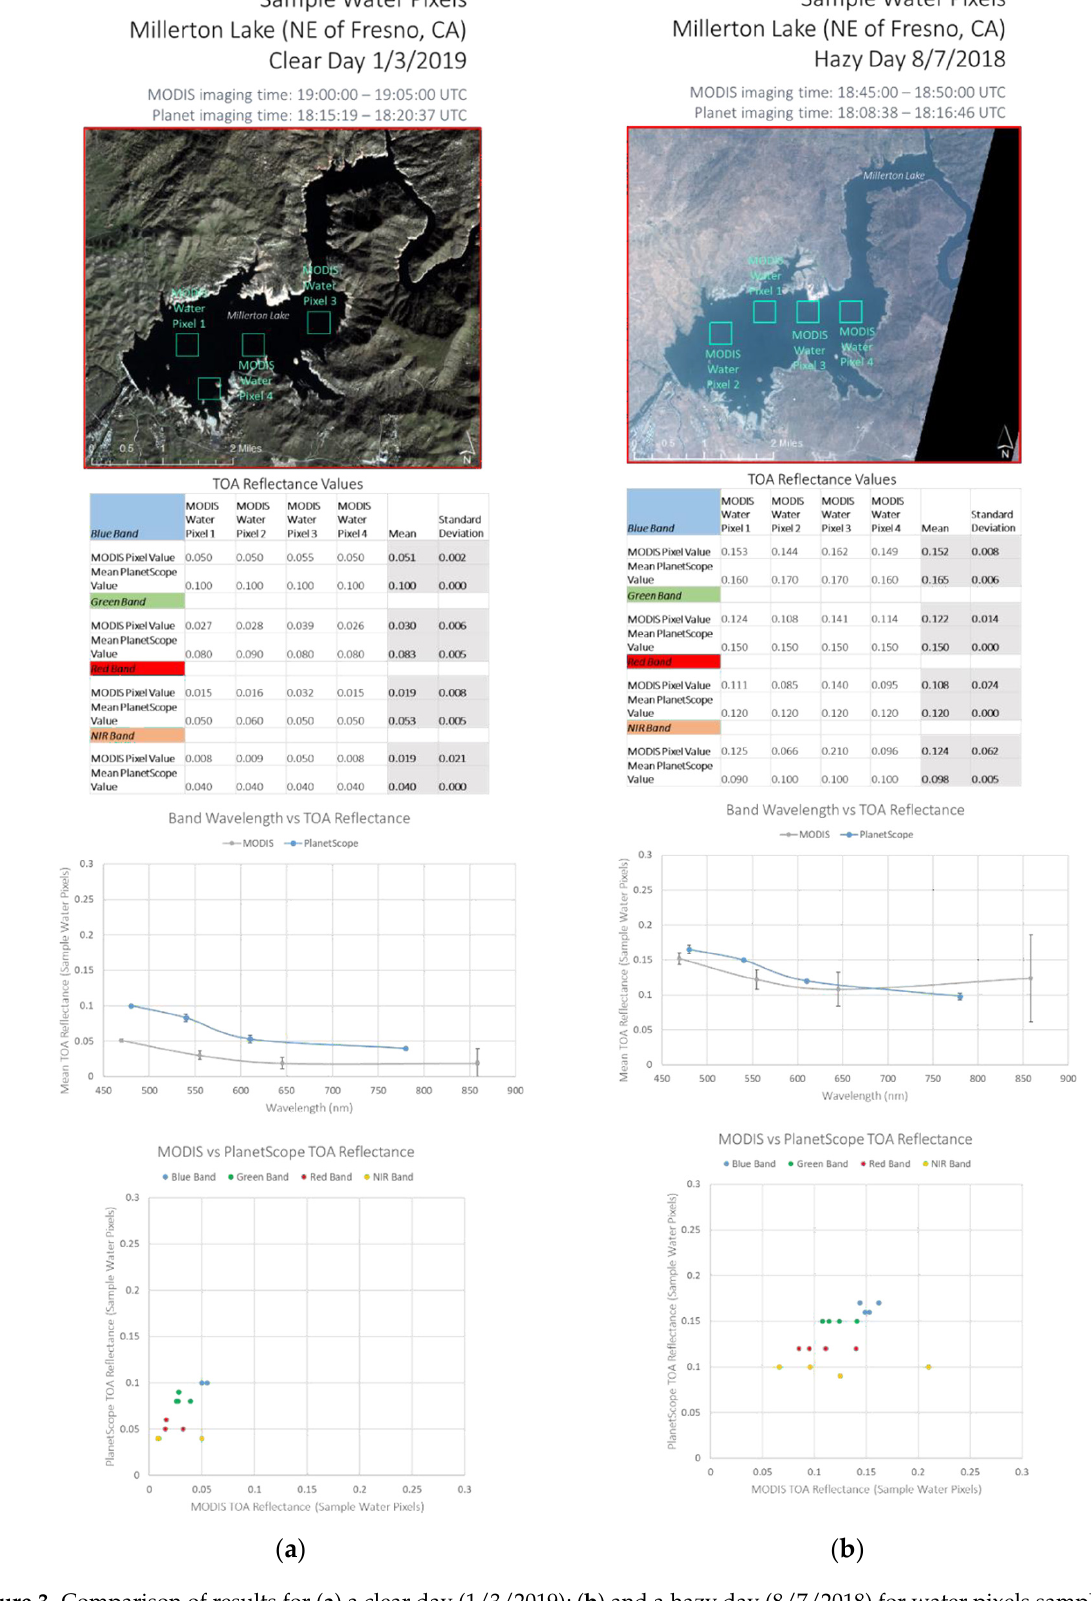
Figure 3. Comparison of results for ( a ) a clear day (1/3/2019); ( b ) and a hazy day (8/7/2018) for water pixels sampled over Millerton Lake near Fresno, CA. Results for other land cover types sampled in the Fresno and Los Angeles study areas can be found in Appendix A Figures A1–A5.